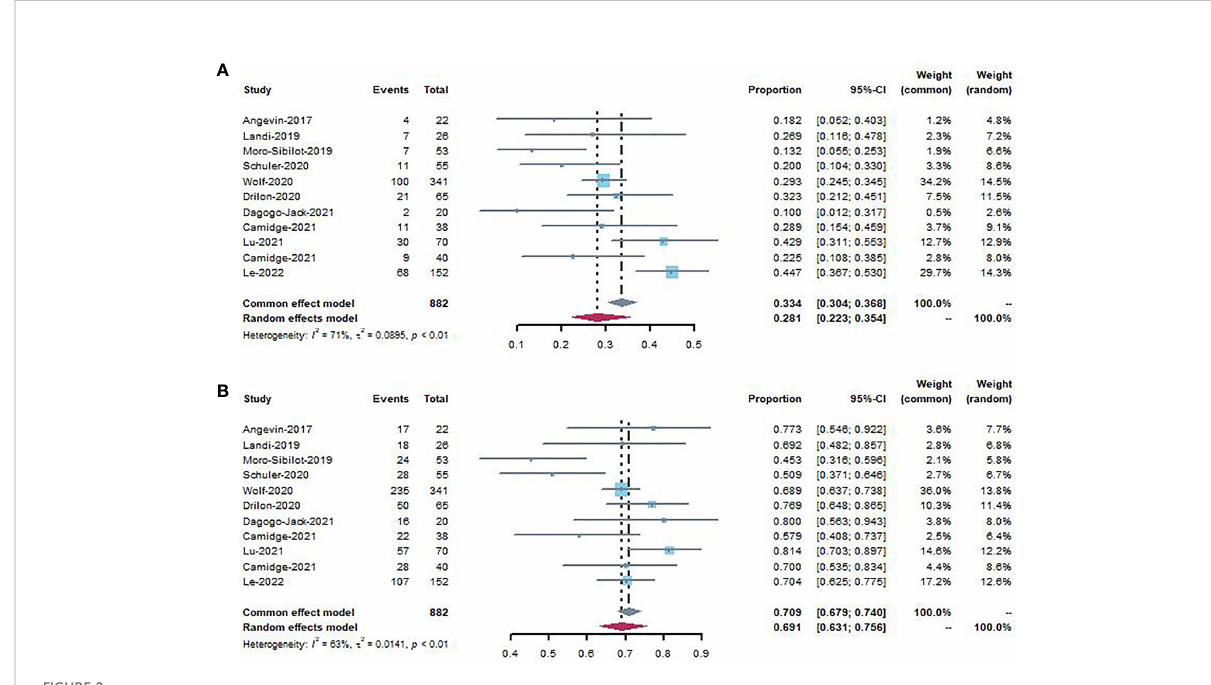
FIGURE 2 Forest plot showing ORR (A) and DCR (B) to patients using MET